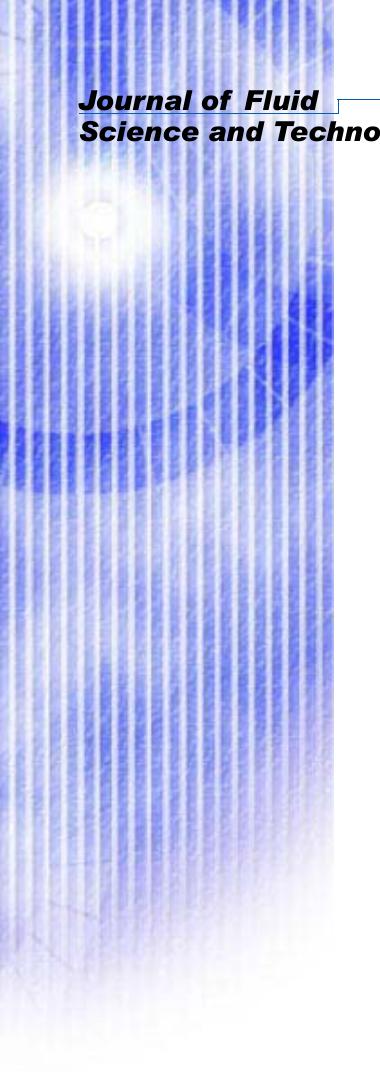
addition, for a given inclination angle φ , the local wall shear stress and local Nusselt number rise with an increase in ξ . It also indicates that rate of increase of the two quantities rises with the increase of ξ . For larger φ , this phenomenon is more significant.